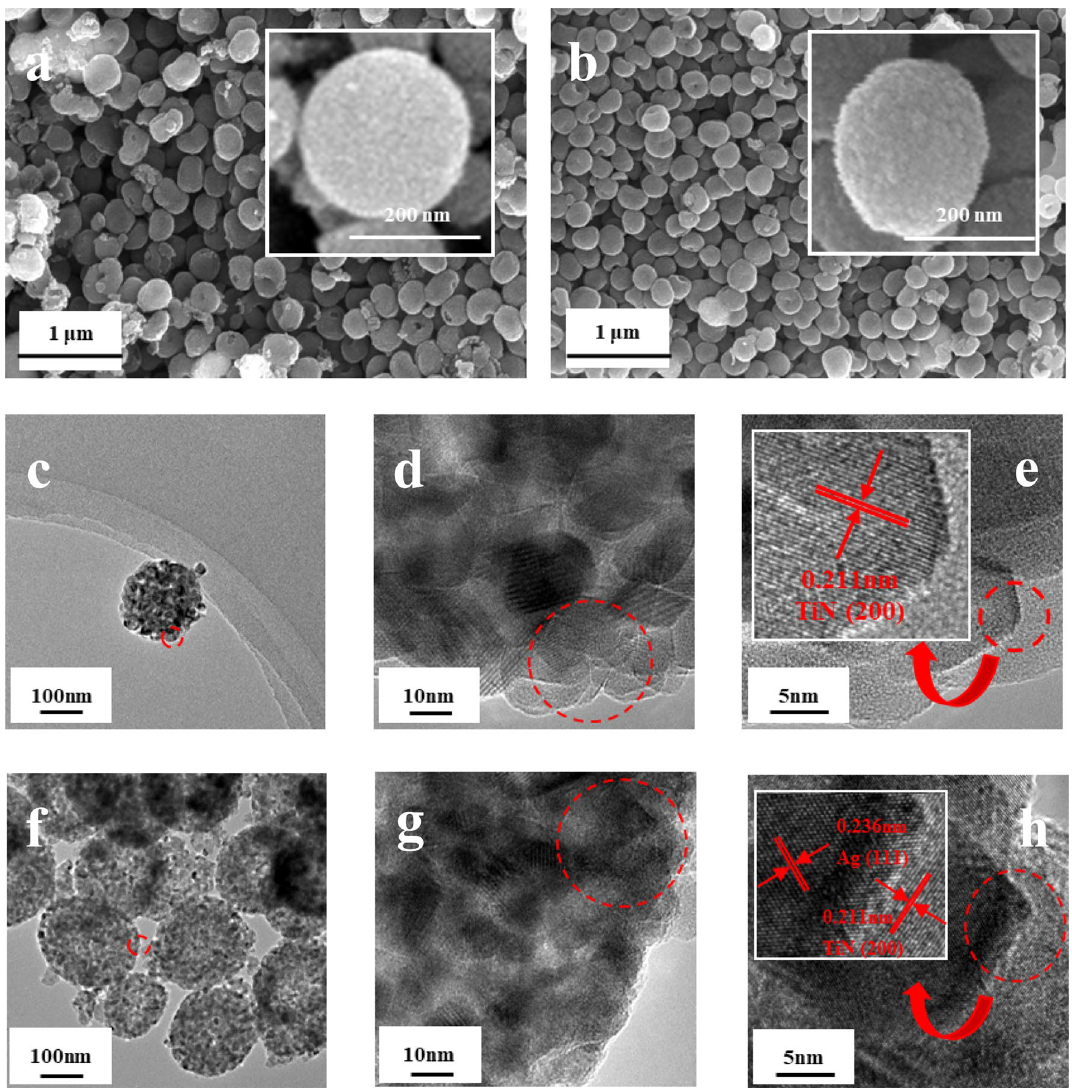
Figure 2. SEM images of TiN/SMS ( a ) and Ag-TiN/SMS ( b ); TEM images of TiN/SMS ( c – e ) and Ag-TiN/SMS ( f – h